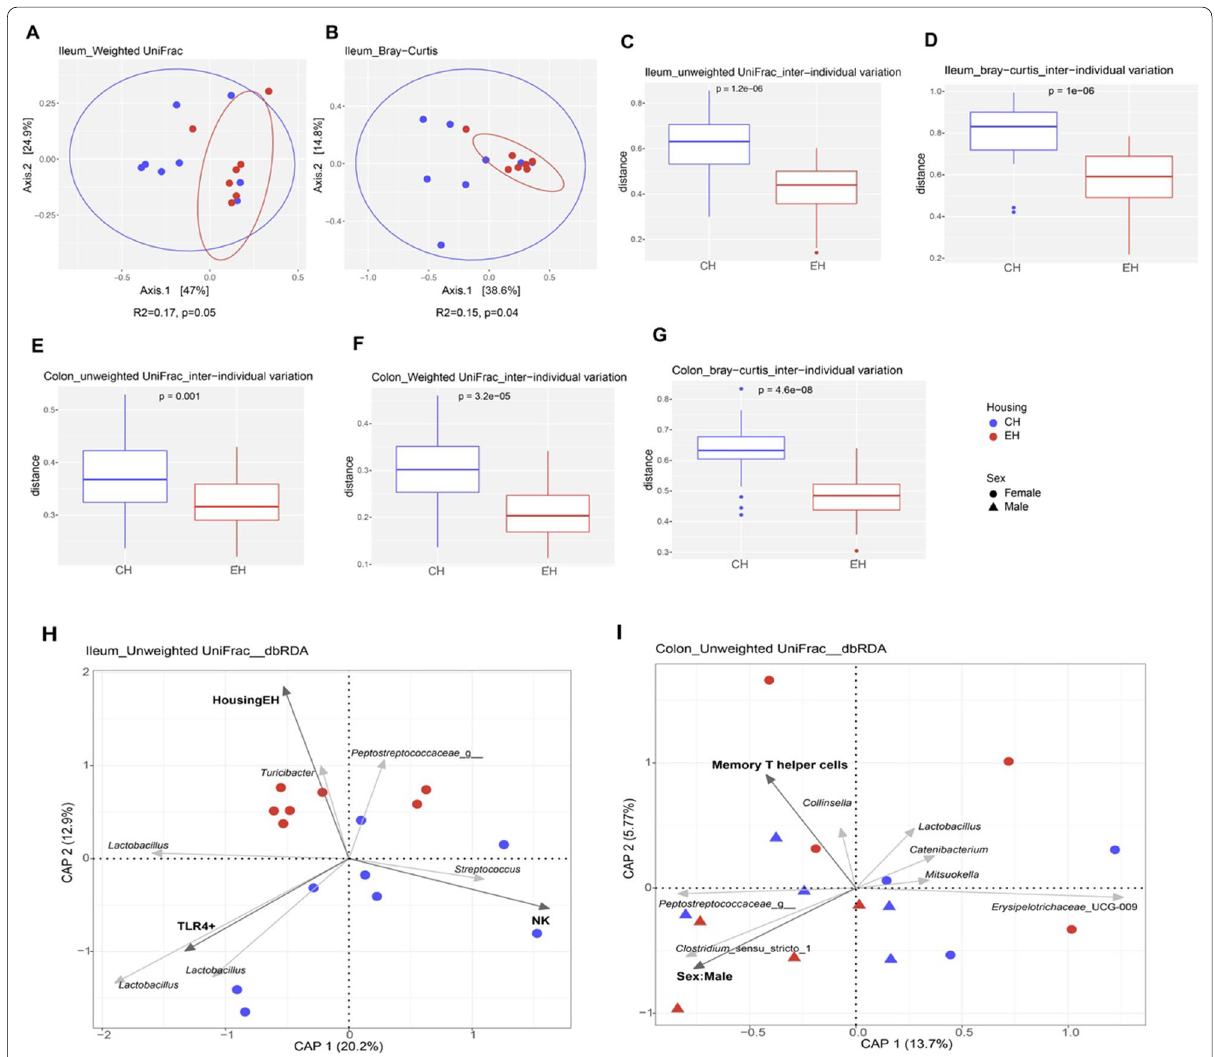
Fig. 6 The effect of housing condition on ileal and colonic microbiota composition. Based on either unweighted or weighted UniFrac pairwise distance or Bray–Curtis pairwise dissimilarity at amplicon sequence variant‑level, A , B Microbial dissimilarities of ileal digesta between CH and EH pigs were assessed by principal coordinate analysis (PCoA) and PERMANOVA. C – G Differences in inter‑individual variation for CH versus EH pigs in ileal and colonic microbiota composition was asessed by Wilcoxon rank sum test . Distance‑based redundancy analysis (db‑RDA) triplots show the association between microbiota variation and environmental variables, focusing on samples from ileum ( H ) and colon ( I ). Blue and red colours represent conventional housing (CH) and enriched housing (EH), respectively. Dark grey arrows indicate environmental variables and light grey arrows show best fitting